Question: Write the caption for this figure.
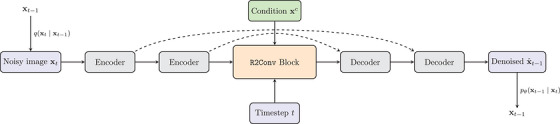
Answer: Diagram of the time dependent equivariant U‐Net for step t of the reverse process of EqDiff‐CT.